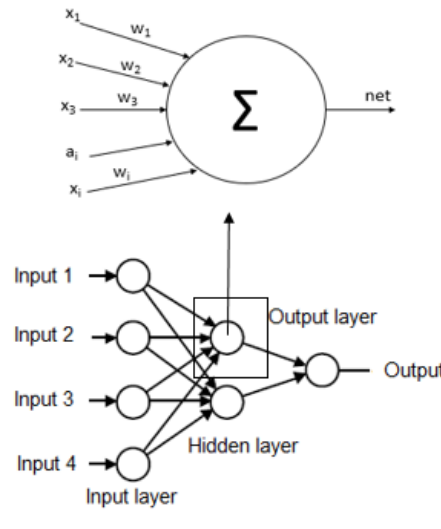
Figure 3. Basic structure of the artificial neural